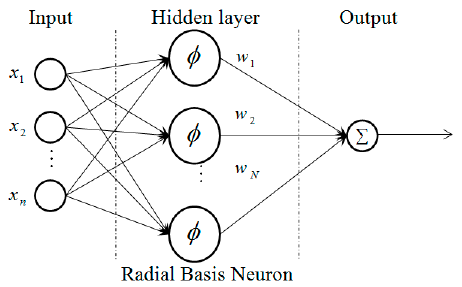
Figure 5. Architecture of the RBF neural network. RBF: radial basis function.